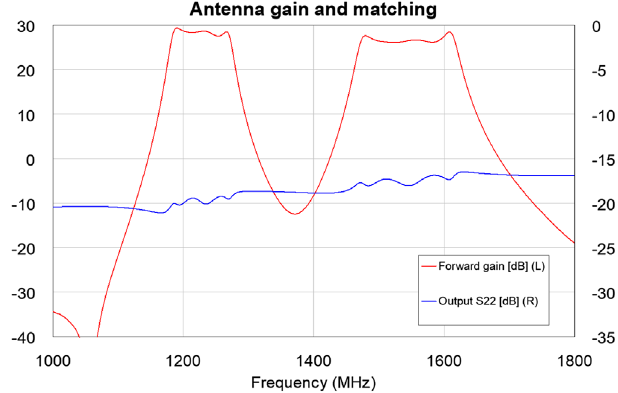
Fig. 9. Showing the performance of the bandpass fi lter and ampli fi ers within the TOPCAT II stacked patch antenna. The gain trace (red) shows a good selection of the L1/L2/L5 bands, and strong rejection of signals outside of these frequency bands. The blue trace shows the return loss at the output.